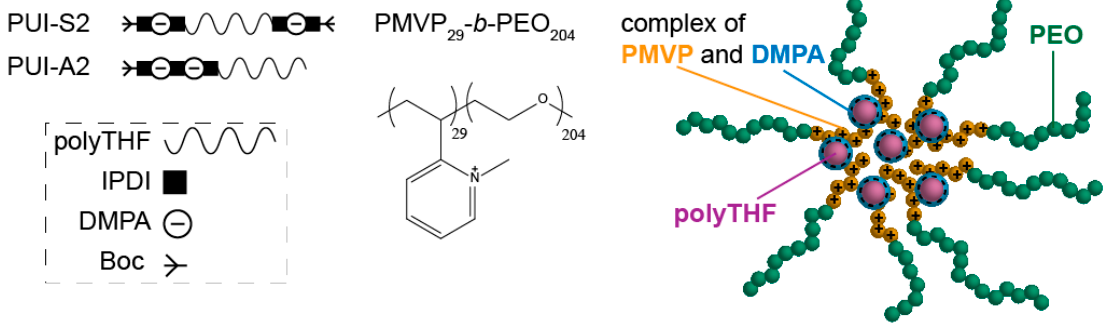
Figure 1. Proposed structure of a surfactant–copolymer complex co-assembled from a sequence-controlled symmetric polyurethane ionomer ( PUI-S2 ) or asymmetric PUI ( PUI-A2 ) (chemical structures in Figure A1) with double hydrophilic diblock copolymer poly(N-methyl-2-vinylpyridinium iodide) 29 - b -poly(ethylene oxide) 204 (PMVP 29 - b -PEO 204 ). PUIs are composed of poly(tetrahydrofuran) (polyTHF), isophorone diisocyanate (IPDI), dimethylpropionic acid (DMPA), and tert-butyloxycarbonyl (Boc). The core–shell surfactant–copolymer complexes contain a core comprising the anionic PUI micelles associated with the cationic PMVP segments of the block copolymer.